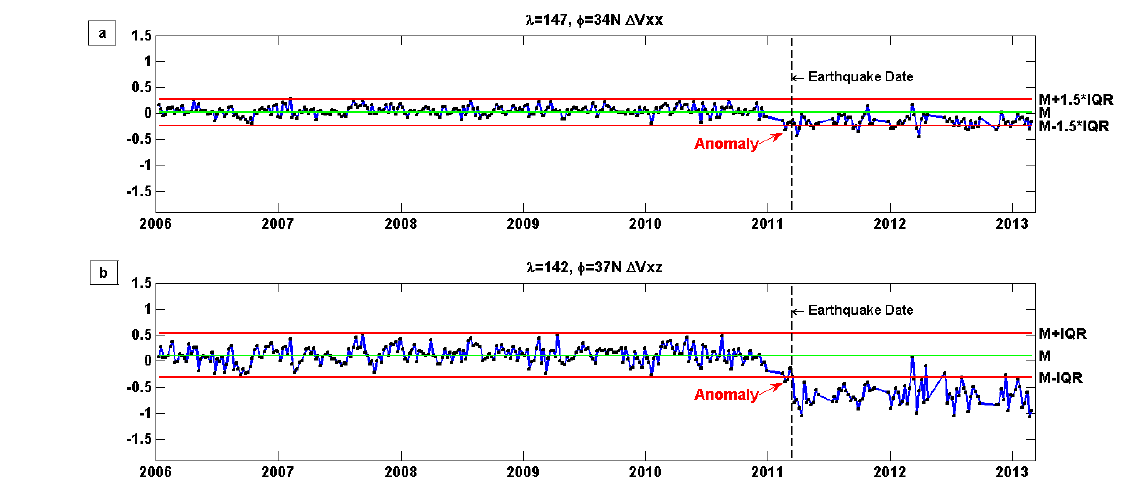
Figure 8. Same as Figure 5 for Tohoku-Oki earthquake